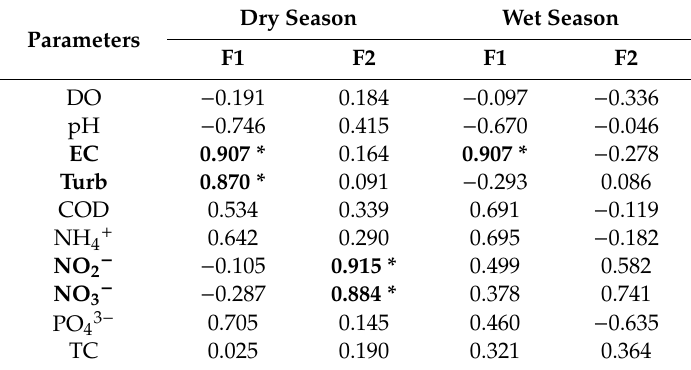
Table A4. Correlations between variables and factors for each